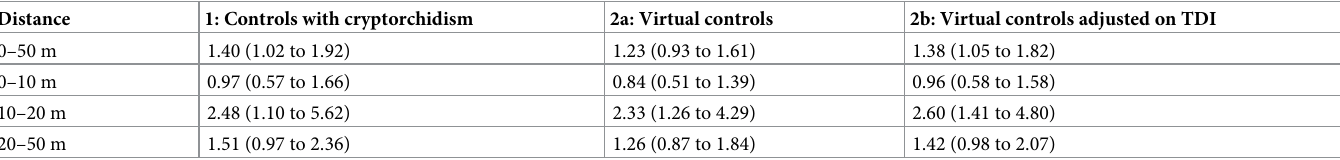
Table 4. Odds ratios, with 95% confidence intervals, of the risk of hypospadias by classes of distance to the closest vineyard. (short distances).